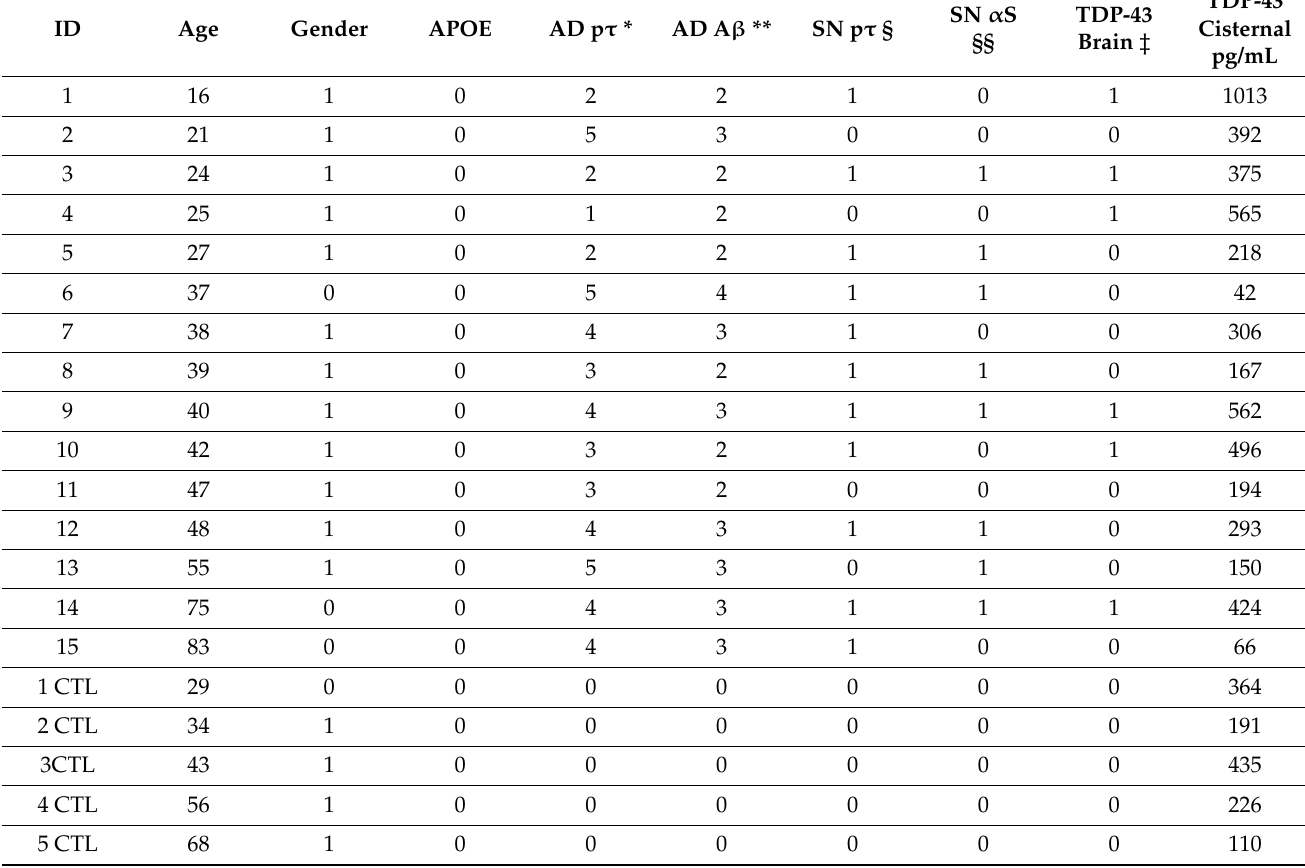
Table 2. Autopsy cases with cisternal CSF TDP-43 and complete neuropathological examination using H&E, PHF-tau8 phosphorylated at Ser199-202-Thr205 and α -synuclein phosphorylated at Ser-129, LB509 and TDP-43